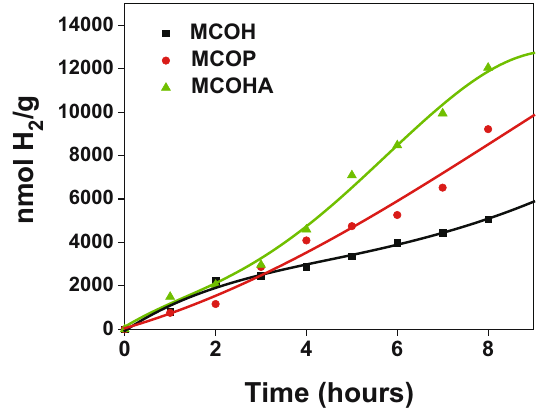
Figure 11: Photocatalytic evaluation of the MCOs synthetized for the hydrogen production.